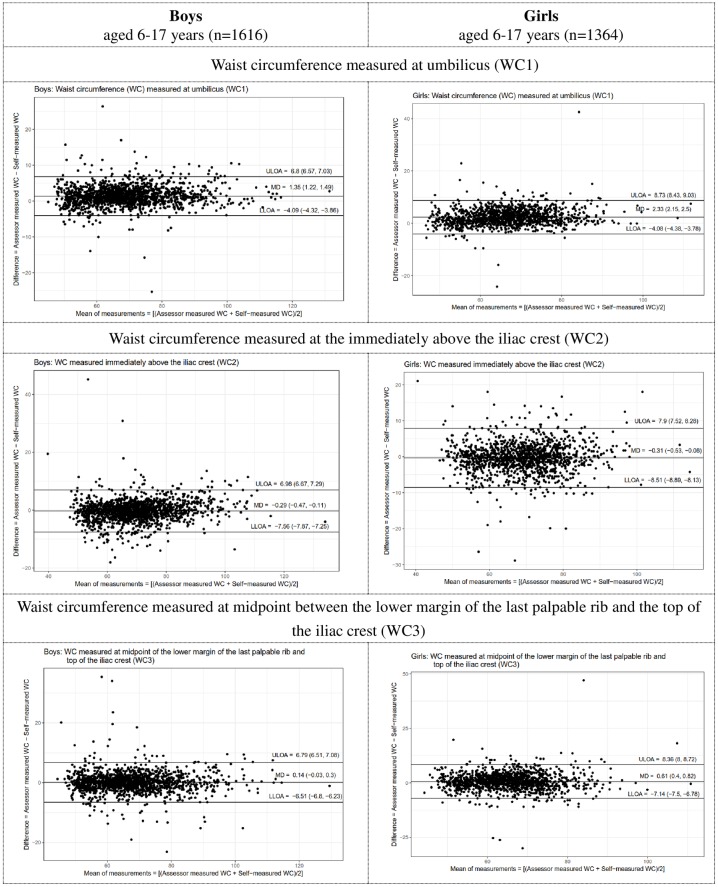
Bland altman plots illustrating the level of agreement between assessor-measured & self-measured WC at 3 WC measurement sites by sex and location.MD: Mean differenceULOA: Upper limits of agreementLLOA: Lower limits of agreement.